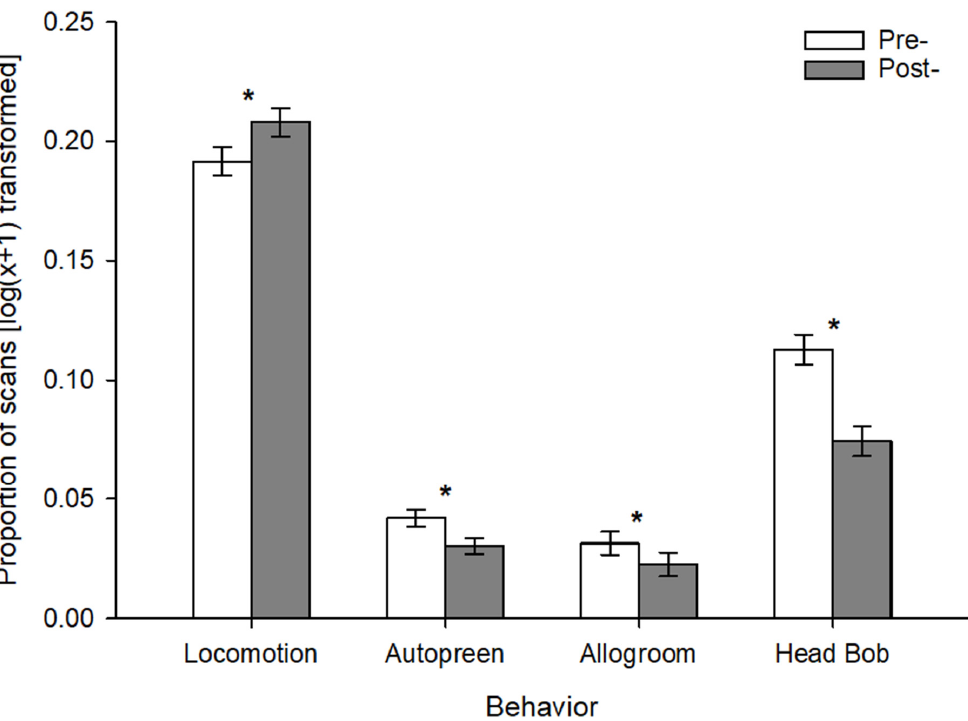
Figure 2. Comparison between proportions of behaviors scored before and after (pre- and post-, respectively) addition of enrichment. Asterisks indicate significant differences between pre- and post- periods for that behavior.